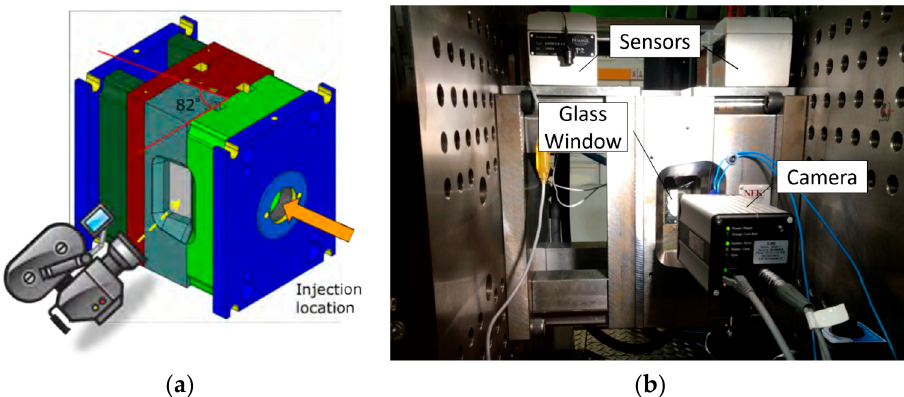
Figure 1. ( a ) Schematic of the mold and of the tilting angle of the glass insert; ( b ) Photograph of the mold setup during an injection molding cycle. It comprises high-speed camera (HSC), glass window and sensors.